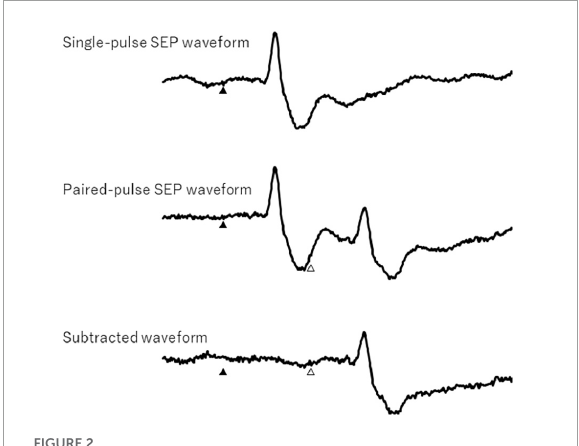
FIGURE2 Single- and paired-pulse somatosensory evoked potential waveforms and subtracted waveform. Filled and open triangles show first and second electrical stimulation, respectively.